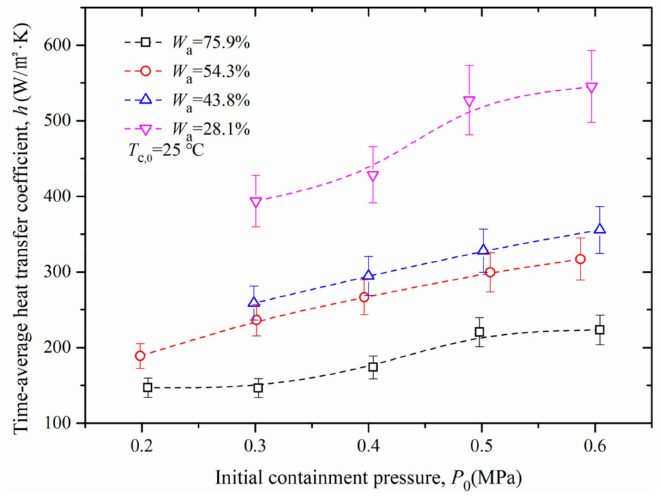
Figure 3. The variation of time-average condensation HTC with initial containment pressure.